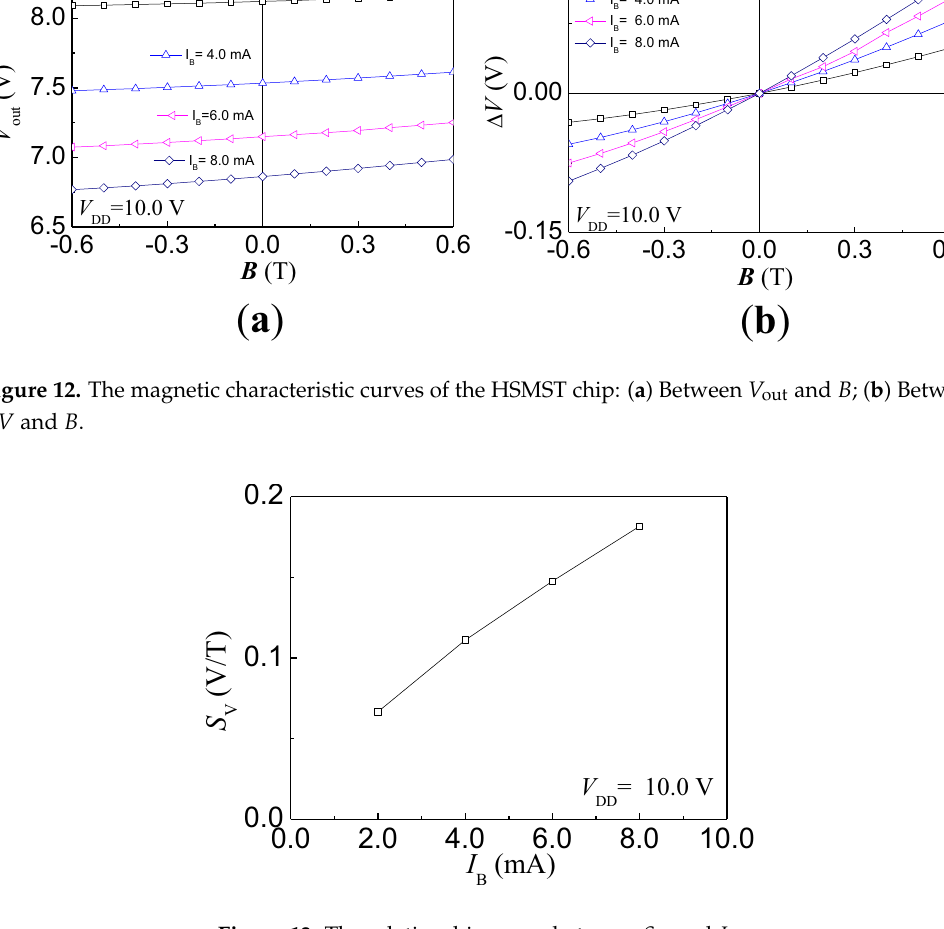
Figure 13. The relationship curve between S V and I B